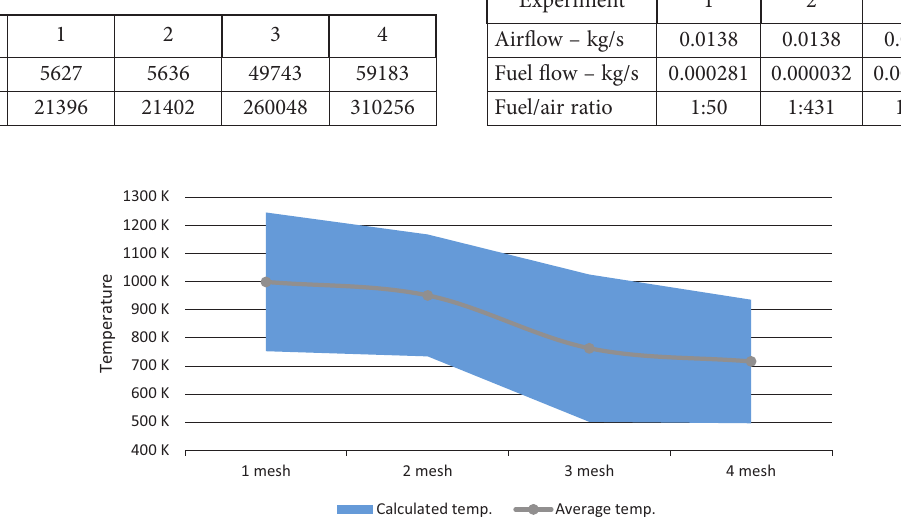
Table 2. Amount of elements and nodes Mesh no.